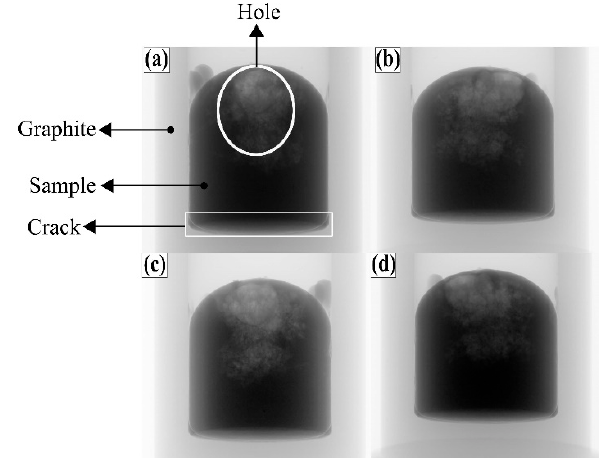
Figure 17. 2D-CT images of graphite crucible with solidified Fe-26.38Si-9.35B alloy at different angle position. ( a ) front view, ( b ) right side view, ( c ) rear view, and ( d ) left side view.